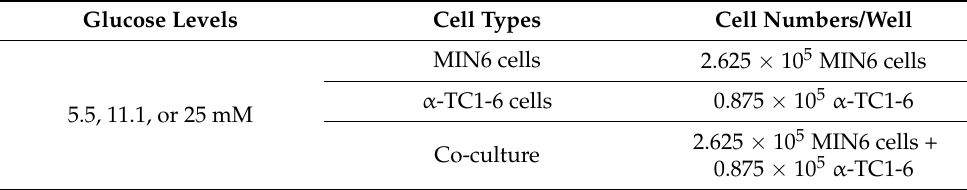
Table 1. Experimental set-up. MIN6 cells and α -TC1-6 cells were mono-cultured or co-cultured in the medium containing 5.5, 11.1, or 25 mM glucose,